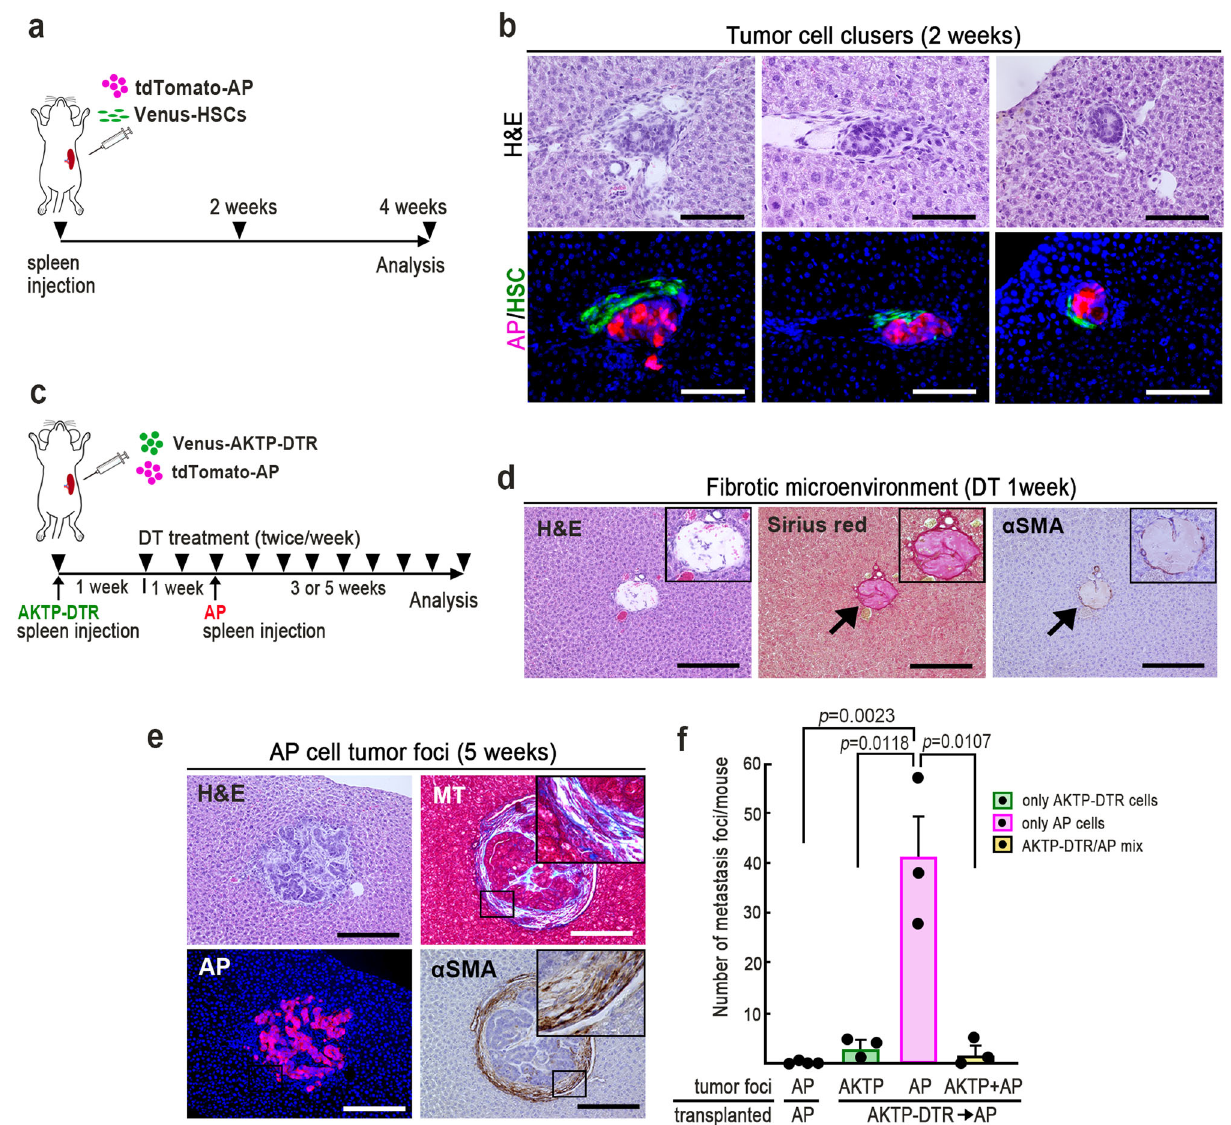
Fig. 5 Fibrotic niche generation for non-metastatic cell colonization. a A schematic illustration of the transplantation experiment with hepatic stellate cells (HSCs). tdTomato-labeled AP cells (red) and Venus-labeled HSCs (green) were mixed and transplanted to the spleen, and liver tissues were examined histologically at two and four weeks after transplantation. b Representative photographs of three independent tumor cell clusters in the liver at two weeks after transplantation. H&E (top) and fl uorescent immunohistochemistry for AP cells (red) and HSCs (green) (serial sections, bottom). Bars, 100 μ m. c A schematic illustration of the transplantation experiment for prior niche generation. Venus-labeled AKTP-DTR cells (green) were transplanted to the spleen, and mice were treated with diphtheria toxin (DT) twice a week starting from one week after transplantation. At one week after DT started, tdTomato-labeled AP cells (red) were transplanted to the spleen, and liver tissues were examined at three to fi ve weeks later. d Representative photographs of H&E (left), Sirius red staining (center), and immunohistochemistry for α SMA (right) at one week after DT treatment. Insets show enlarged images. Arrows indicate deposited collagen fi bers (center) and α SMA-positive cells (right). Bars, 100 μ m. e Representative photographs of tumor lesions consisting of AP cells at fi ve weeks after AP cell transplantation. H&E, Masson ’ s trichrome staining (MT) and immunohistochemistry for tdTomato (AP) and α SMA. Insets indicate enlarged images of the boxed areas. Bars, 100 μ m. f The numbers of liver metastasis foci consisting of only AKTP-DTR cells (green), only AP cells (magenta), and a mixture of AKTP-DTR and AP cells (yellow) at three to fi ve weeks after AP cell transplantation are shown as a bar graph. The numbers of metastasis foci at four weeks after AP cell transplantation to control mice are also indicated (left). ( n = 4 biologically independent animals for control; and n = 3 biologically independent DT-treated animals for each experimental condition.) The data in f are presented as the mean ± s.d. A two-sided unpaired t -test was used to calculate the signi fi cance of differences, and p values are provided. The photographs in b , d , and e are representative images from n = 3 biologically independent animals. Source data are provided as a Source Data For co-transplantation experiments using HSCs and AP cells (Fig. 5), 3 × 10 5 For serial transplantation experiments (Supplementary Fig. 3), 2.5× 10 5 of Venus-labeled AKTP cells were injected into the spleen of NSG mice, followed by of Venus-labeled HSCs and AP cells were co-cultured overnight on ultra- direct injection of 5 ×10 5 of tdTomato-labeled AKTP, AT, or AP cells into the low-attachment culture dishes (Corning) to generate chimeric aggregations and transplanted to the NSG mouse spleen. Liver tissues were examined portal vein at 2 weeks after spleen transplantation. Liver tissues were examined histologically at 2 and 4 weeks after transplantation ( n = 3 mice for each histologically at 5 weeks after spleen transplantation ( n = 4 – 6 mice for each experiment). genotype combination).